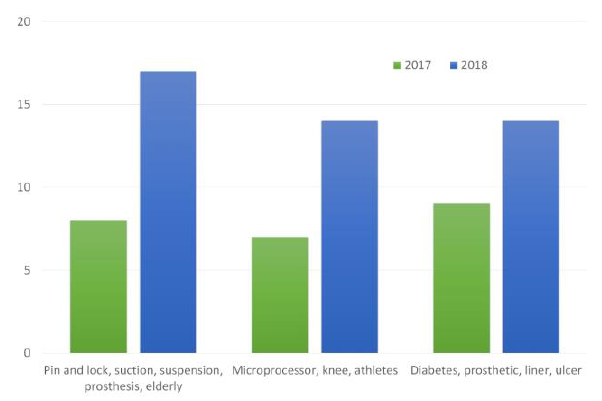
Figure 1: Changes in the number of freely accessible articles among the top 20 search results for Google Scholar searches between March 2017 and March 2018.